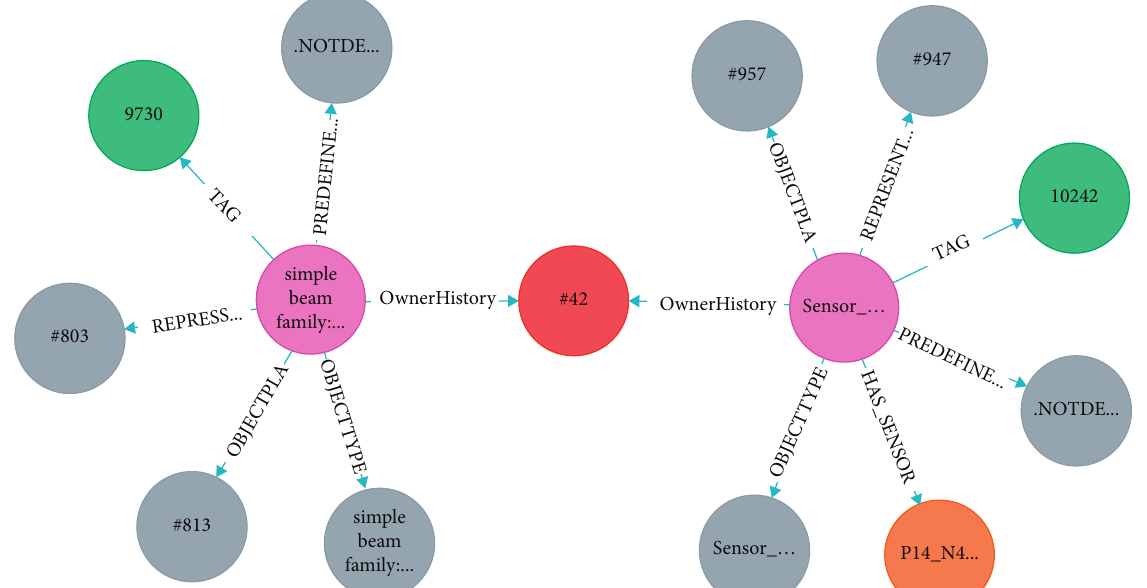
Figure 11: Getting the beam and sensor instances and their attributes.